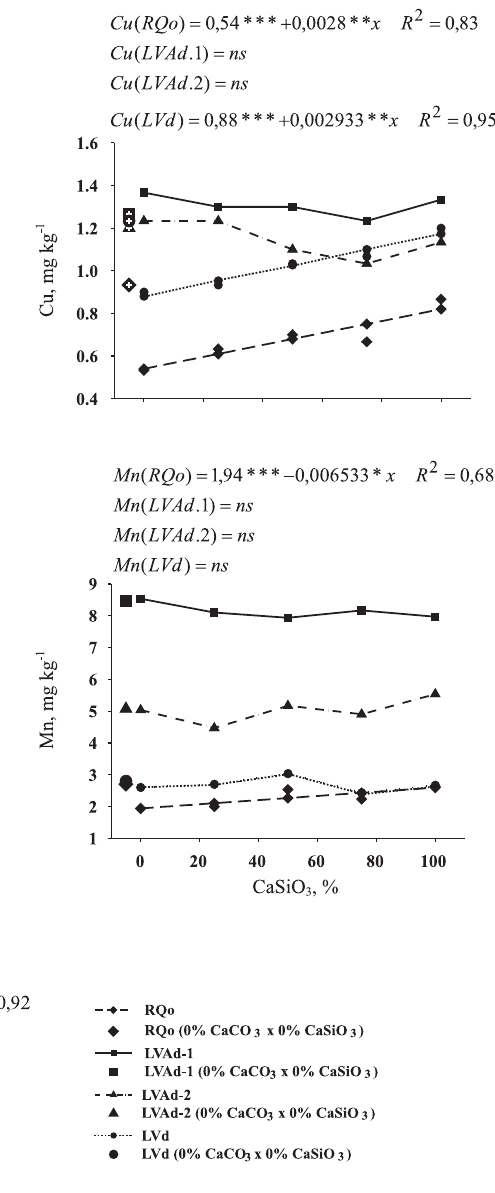
por CaSiO sobre os teores de Zn, Cu, B, Mn e Si nos solos RQo, 3 3 4. A maior inclusão de silicato proporcionou redução na disponibilidade de Zn no solo RQo. Nos solos LVAd-1, LVAd-2 e LVd, não foram observados efeitos significativos da maior proporção de silicato sobre os teores de Zn.